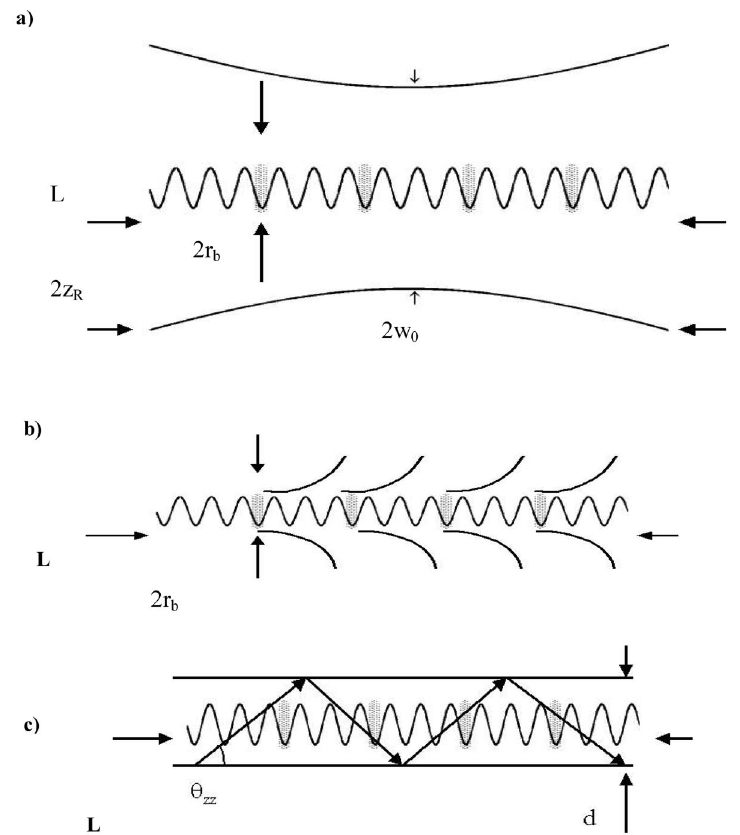
FIG. 1. Superradiant emission of an undulating, finite width, bunched e -beam: (a) emission into a free-space radiation mode , (b) diffraction-dominated emission of wavelets in free space in a long wiggler, and (c) emission into (Gaussian wave) of waist size w 0 a single waveguide mode characterized by ray zigzag angle (cid:27) ZZ